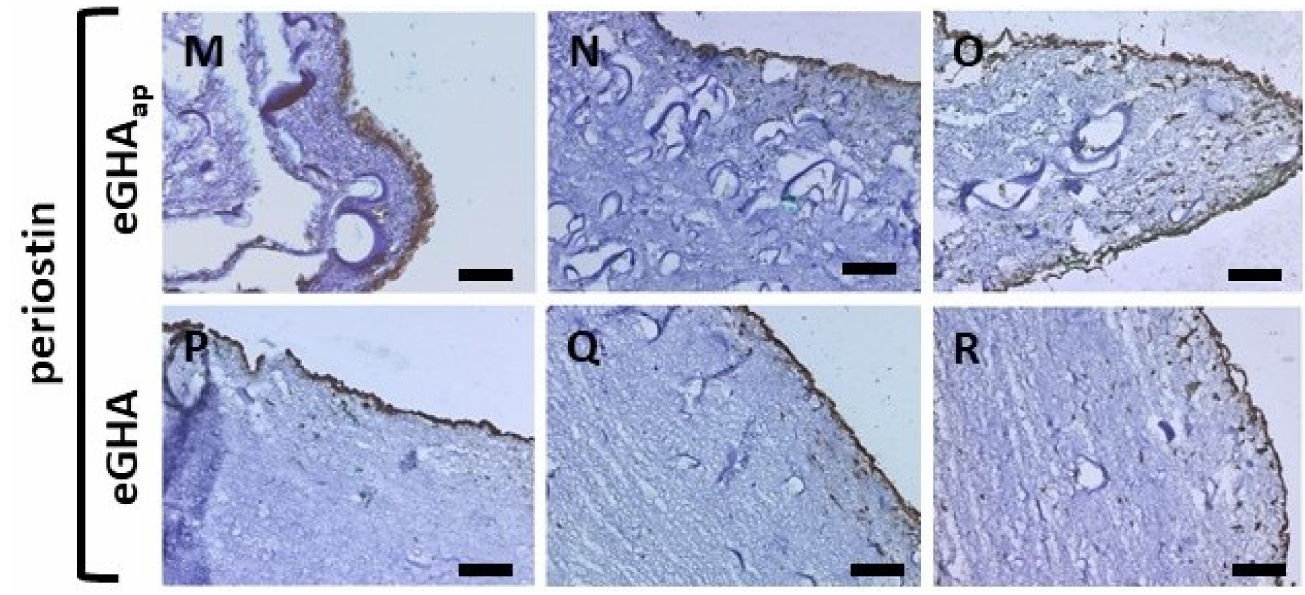
Figure 6. Immunohistochemical evaluation of eGHA and eGHA ap scaffolds populated with hMSCs, PDLFs, and cocultures of both cell types. After an incubation period of 21 d, the constructs were fixed and incubated with primary antibodies against Oct4 ( A – F ), osteopontin ( G – L ), and periostin ( M – R ) and stained with the peroxidase-dependent 3,5-diaminobenzidine reaction (DAB; brown color). Subsequently, immunohistochemical staining for the mesenchymal cytoskeletal filament vimentin (HistoGreen staining; green color) was performed for all sections to detect all cells. Finally, hematoxylin counterstaining was applied. For each protein of interest, hMSCs ( A , D , G , J , M , P ), PDLFs ( B , E , H , K , N , Q ), and cocultures ( C , F , I , L , O , R ) grown on either eGHA ap ( A – C , G – I , M – O ) or eGHA ( D – F , J – L , P – R ) were examined. The orientation of the representative pictures follows the same rules as in Figure 3. Staining results were evaluated visually and only qualitatively. ( A , D ) Oct4 was expressed mainly in hMSCs and detectable in only a few PDLFs ( B , E ). The inset in ( D ) represents a higher magnification of the section, illustrating the nuclear localization of Oct4. Osteopontin, a marker protein of hard tissues, was expressed predominantly in the nonwovens populated with cocultures ( I , L ). The periodontium-related marker periostin was found mainly in the cocultures ( O , R ) or PDLFs ( N , Q ), but barely in hMSCs ( M , P ). The white arrows in ( A , B , D , F ) exemplarily indicate positively stained cells, which are otherwise hard to recognize. Scale bars represent 100 µ